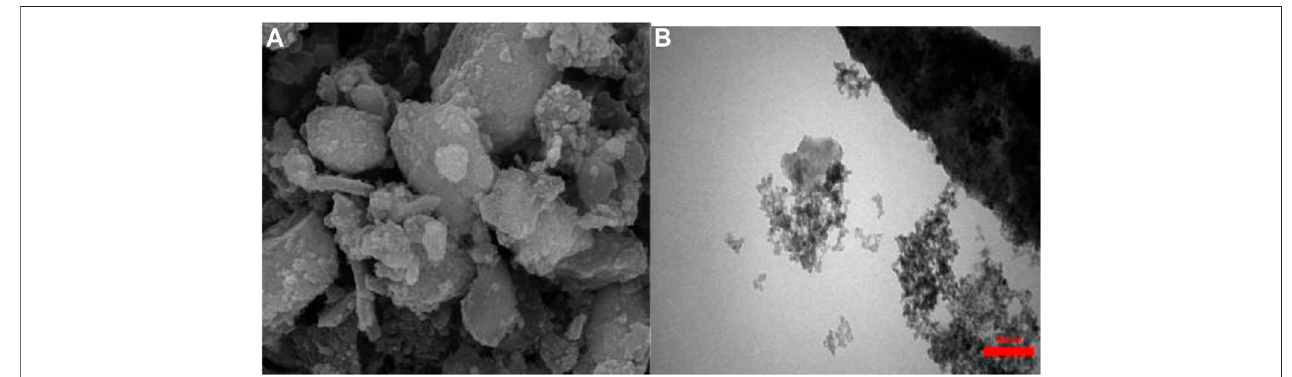
FIGURE 7 | (A) FE-SEM and (B) TEM image of reused synthesized catalyst in the sixth run.